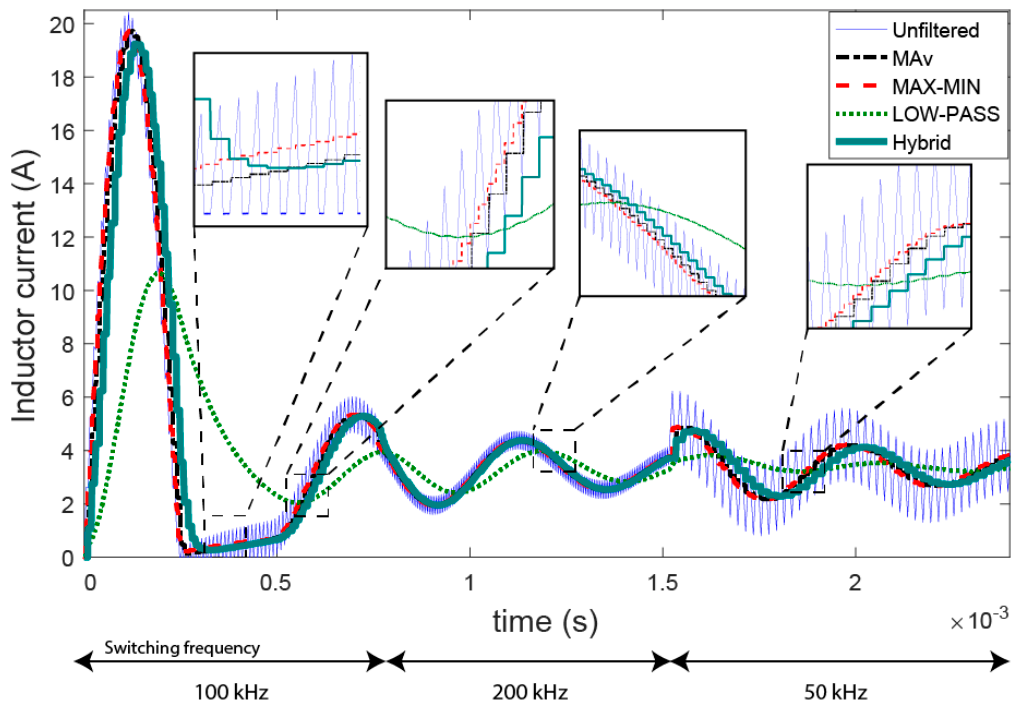
Figure 9. Comparison of the filters applied to the inductor current of a buck converter model.